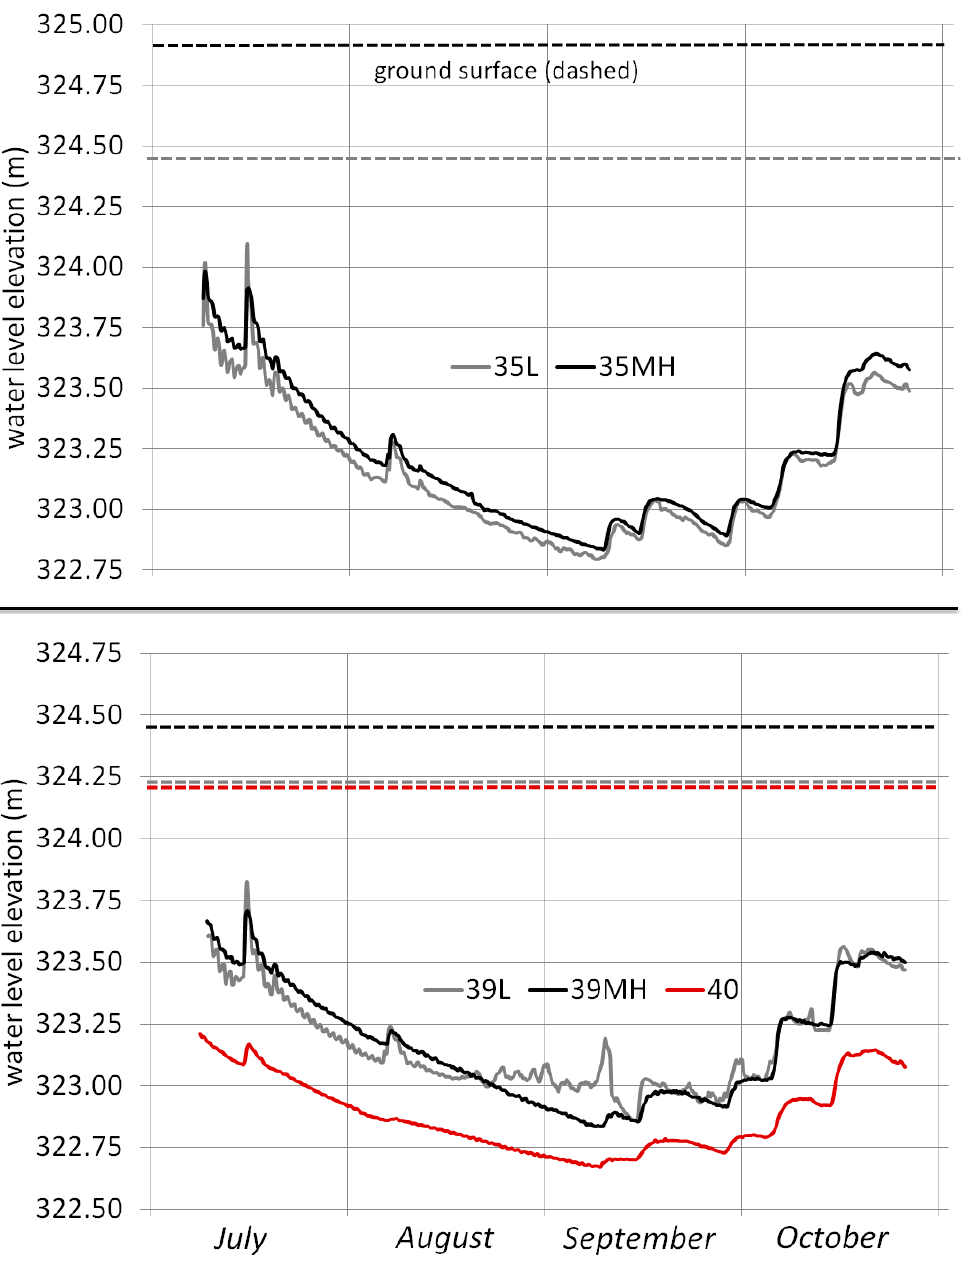
Figure 7. Synchronous, near-continuous log of water levels beneath adjacent dune and swale features along profiles 35, 39, and 40 in the east quadrant, monitored in 2013. The dashed lines show the ground surface elevation at the monitoring points. The suffix on the profile numbers refer to the observation well located in the swale (L) and between the profile topographic midpoint and top of the dune (MH).